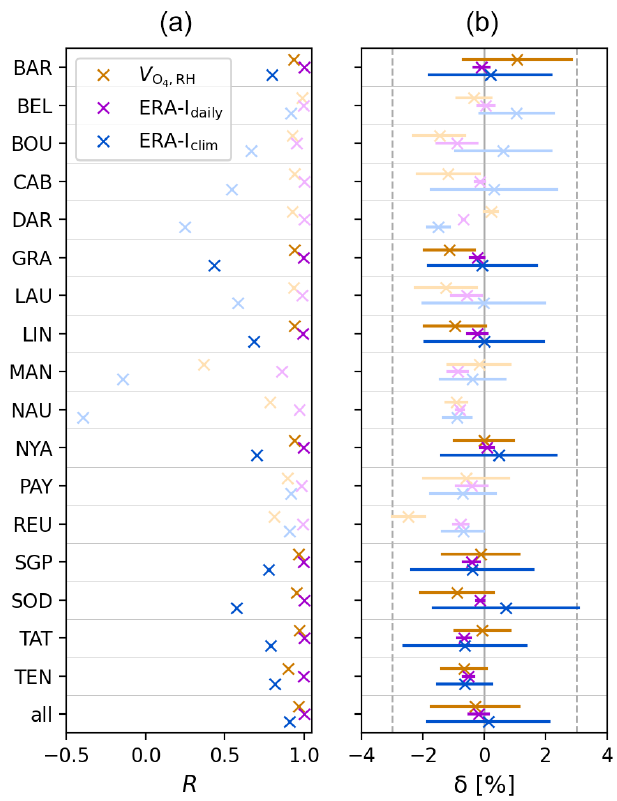
Figure 8. Comparison to the true O 4 VCD in terms of temporal correlation coefficient (a) and deviation δ according to Eq. (19) (b) for all GRUAN stations for O 4 VCDs calculated from (a) Eq. (14) based on GRUAN surface values (orange), (b) daily ERA-Interim profiles (purple) and (c) profiles from the ERA-Interim climatology (blue), interpolated to the GRUAN measurements in space and time. Light colors indicate stations with fewer than 100 profiles (compare Table